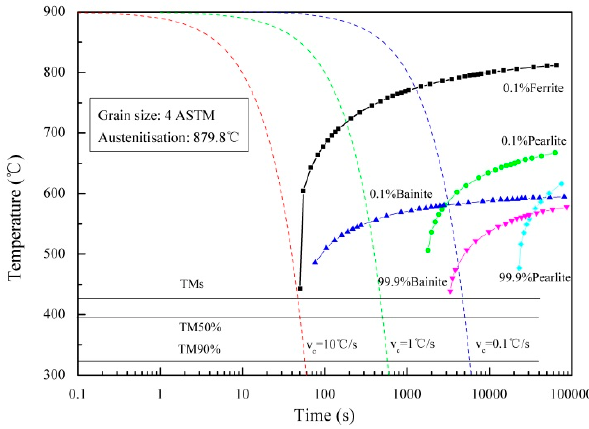
Figure 1. Continous Cooling Transformation (CCT) curve of microalloyed steel calculated by Jmatpro.